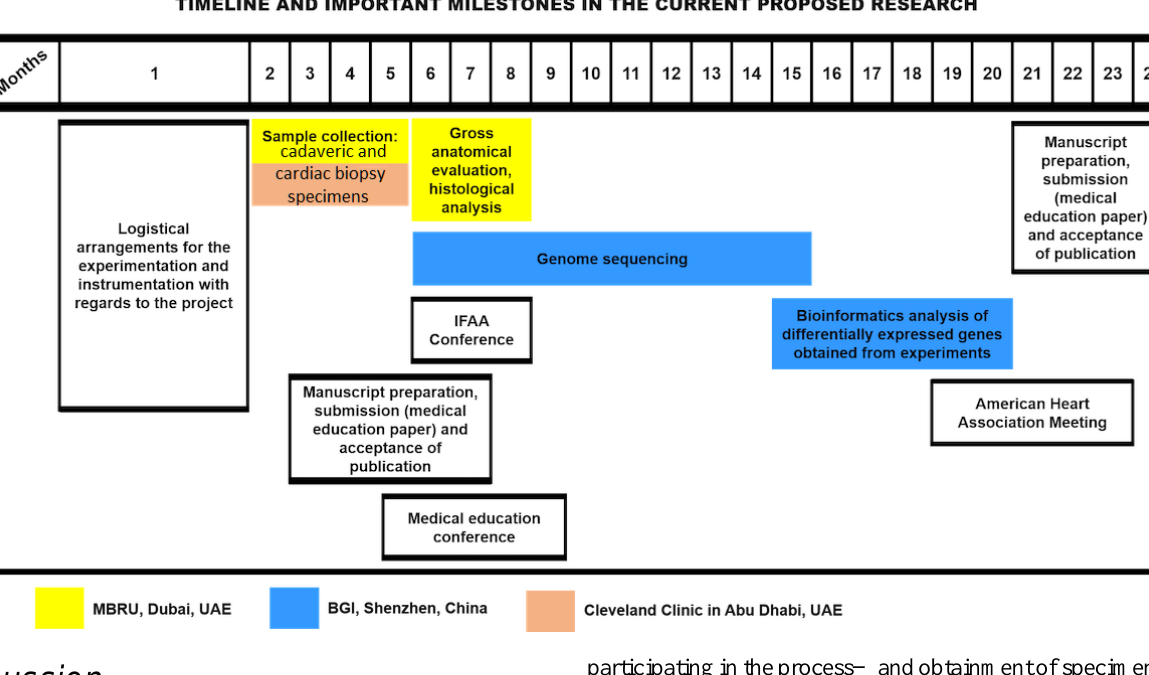
Figure 8. Timeline and key milestones for the study; the sites where the research will be conducted are also indicated. BGI: Beijing Genomics Institute; IFAA: International Federation of Associations of Anatomists; MBRU: Mohammed Bin Rashid University of Medicine and Health Sciences; UAE: United Arab